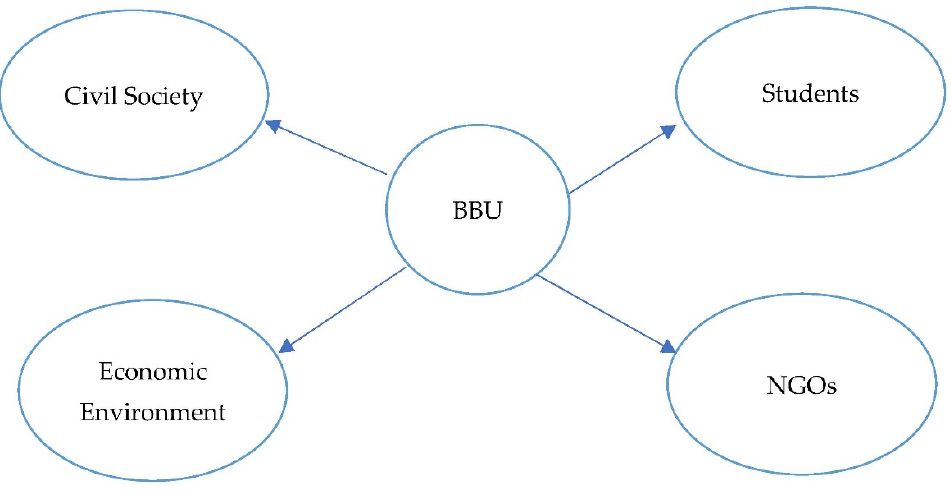
Figure 1. Relevant Stakeholders for SDGs